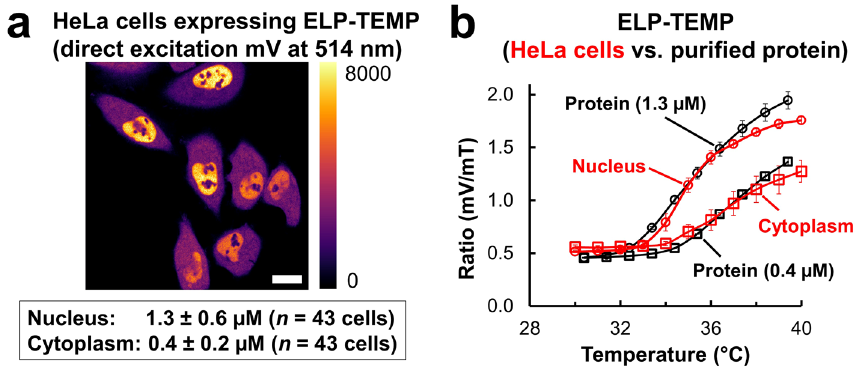
Figure 6. Investigation of the difference in fluorescence ratios of ELP-TEMP between the nucleus and cytoplasm. ( a ) Fluorescence image of mV signal in ELP-TEMP by direct excitation at 514 nm observed by a confocal microscope. The mV fluorescence intensity in the nucleus was measured to be 3.3-fold higher than that in the cytoplasm. From the calibration curve (Fig. S9), the ELP-TEMP concentration in the nucleus and cytoplasm was estimated to be 1.3 ± 0.6 µM and 0.4 ± 0.2 µM ( n = 43 cells), respectively. The color bar indicates fluorescence intensity of mV. Scale bar, 20 μm. ( b ) Comparison of temperature response of ELP-TEMP in HeLa cells measured by confocal microscopy (Fig. 3b) with that of purified protein at concentrations of 1.3 and 0.4 µM in a PBS solution containing 14% w/w Ficoll PM70 by fluorescence spectroscopy. The correlation coefficients between the fluorescence ratios from cells and purified protein were 0.995 and 0.999 for nucleus and cytoplasm, respectively, where the data points on the trajectories of purified protein were interpolated by spline curves. For comparison with the microscopy data, we calculated the integral of F ( λ ) T ( λ ) for mT and mV, where F is a fluorescence emission intensity at a wavelength λ and T is a composite spectral transmittance of a bandpass filter and a dichroic mirror. The integration wavelengths were 457–500 nm and 526–552 nm for mT and mV, respectively. Additionally, we directly measured the temperature of the ELP-TEMP solution with the same thermometer used for the microscopy observation. The excitation was 430 nm. Data are mean ± SD ( n =